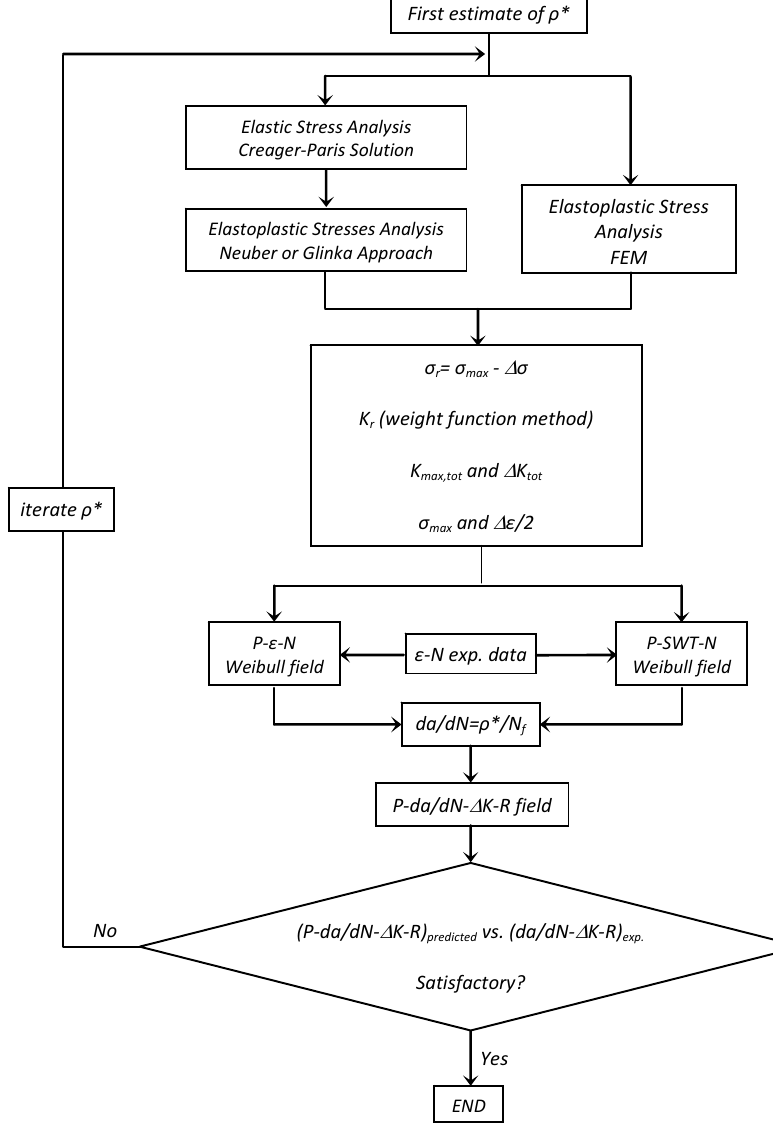
Figure 4: Procedure to generate probabilistic fatigue crack propagation